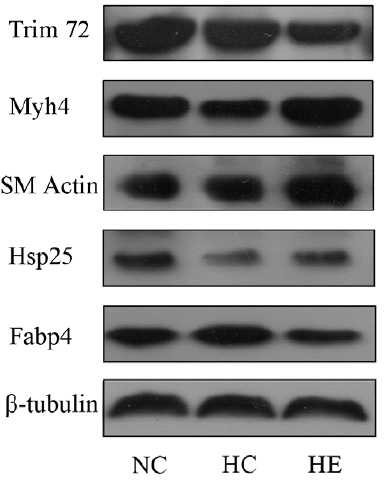
Figure 5. Selected proteins from 2-DE were confirmed by immunoblot analysis. Expression of Trim72, Myh4, Skeletal Muscle Actin (SM Actin), Hsp25 and Fabp4 were assessed by western blot analysis of skeletal muscle proteins from NC, HC, and HE mice; b -tubulin was used as an internal control for loading.